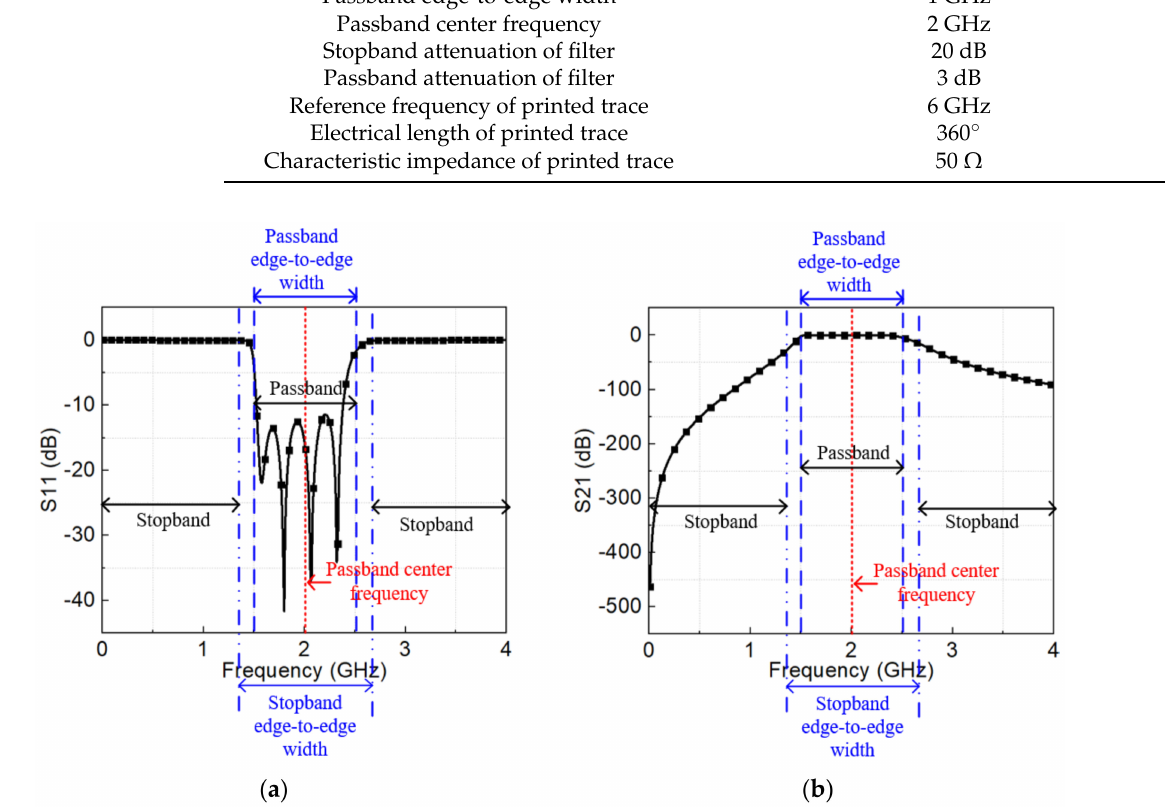
Figure 13. S-parameters of the filter circuit without fault ( a ) S 11 , ( b ) S 21